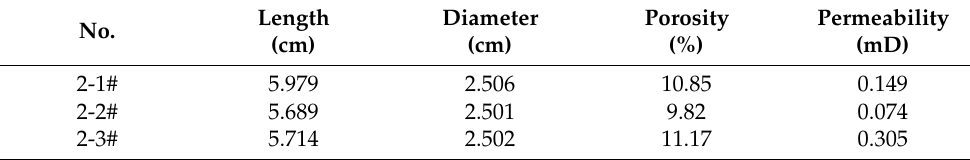
Figure 1. Rock slab size diagram. Table 2. Porosity and permeability analysis